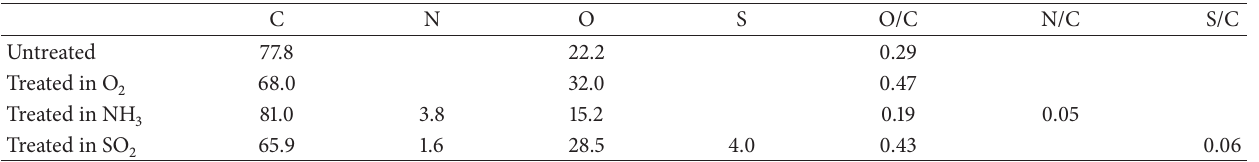
Table 1: Surface composition of plasma-treated